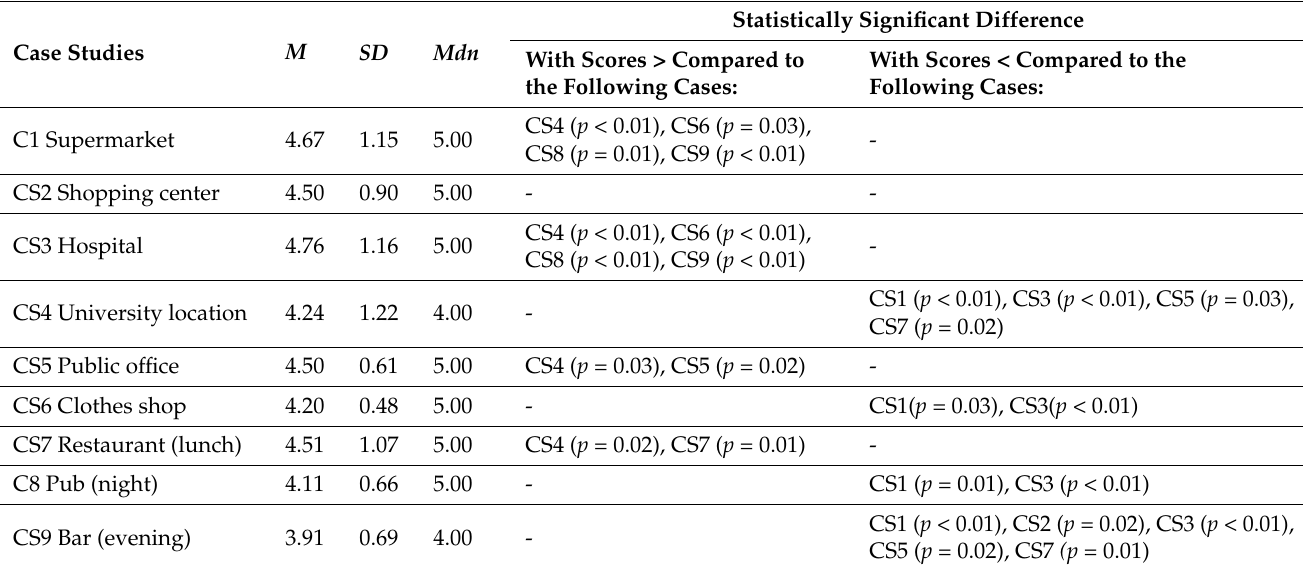
Table A12. Table shows the statistically significant differences ( p (BH)) that emerged from the comparison of item 9 in the different case studies (CS1–CS9). In the table is also reported the mean ( M ), the standard deviation ( SD ) and the median ( Mdn ). Own processing.